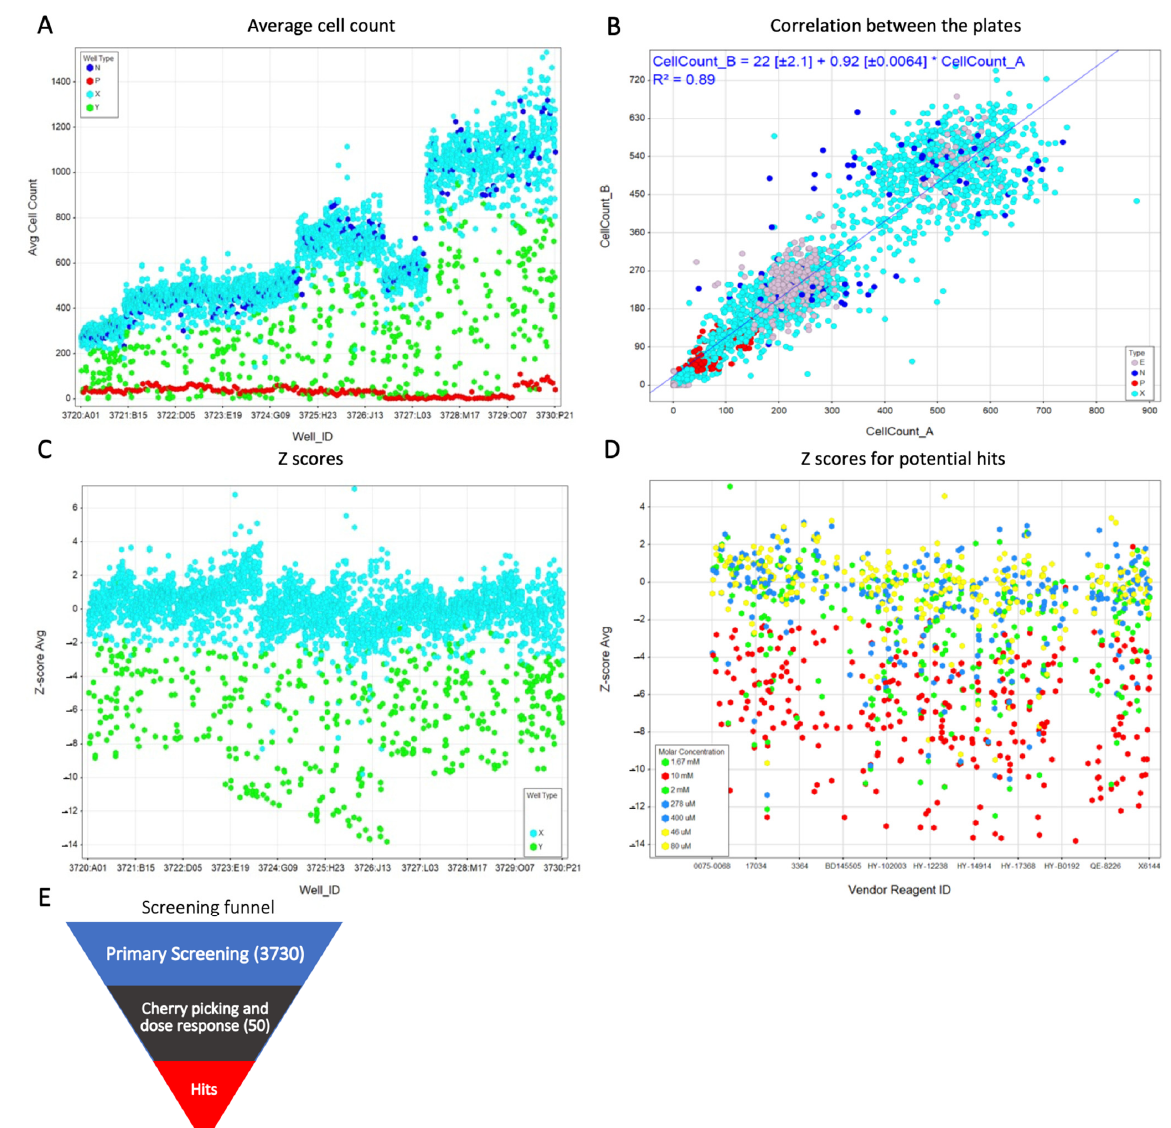
Figure 2. Small molecule screening identifies potential hits. ( A ) Average cell number was plotted for all the plates screened. Red represents positive controls, dark blue represents negative control, light blue represents non-hit compounds, and green represents potential hits. ( B ) Representative plot for the correlation of replicate plates shows a high correlation between replicates. Red represents positive controls, dark blue represents negative control, light blue represents non-hit compounds, and gray represents potential hits. ( C ) Average Z-scores for each compound were calculated and plotted. Light blue represents non-hit compounds, and green represents potential hits. ( D ) Z-scores for various concentrations of selected potential hits were calculated. ( E ) Summary of primary screening showing a number of compounds for cherry-picking and confirmation of potential hits